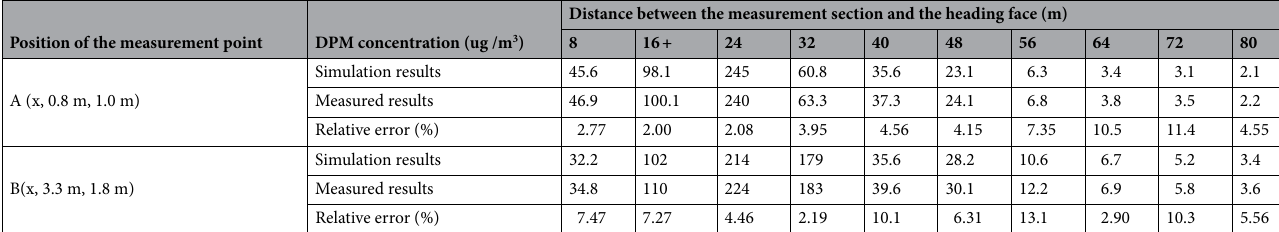
Table 3. Simulated and measured values of DPM at the measurement